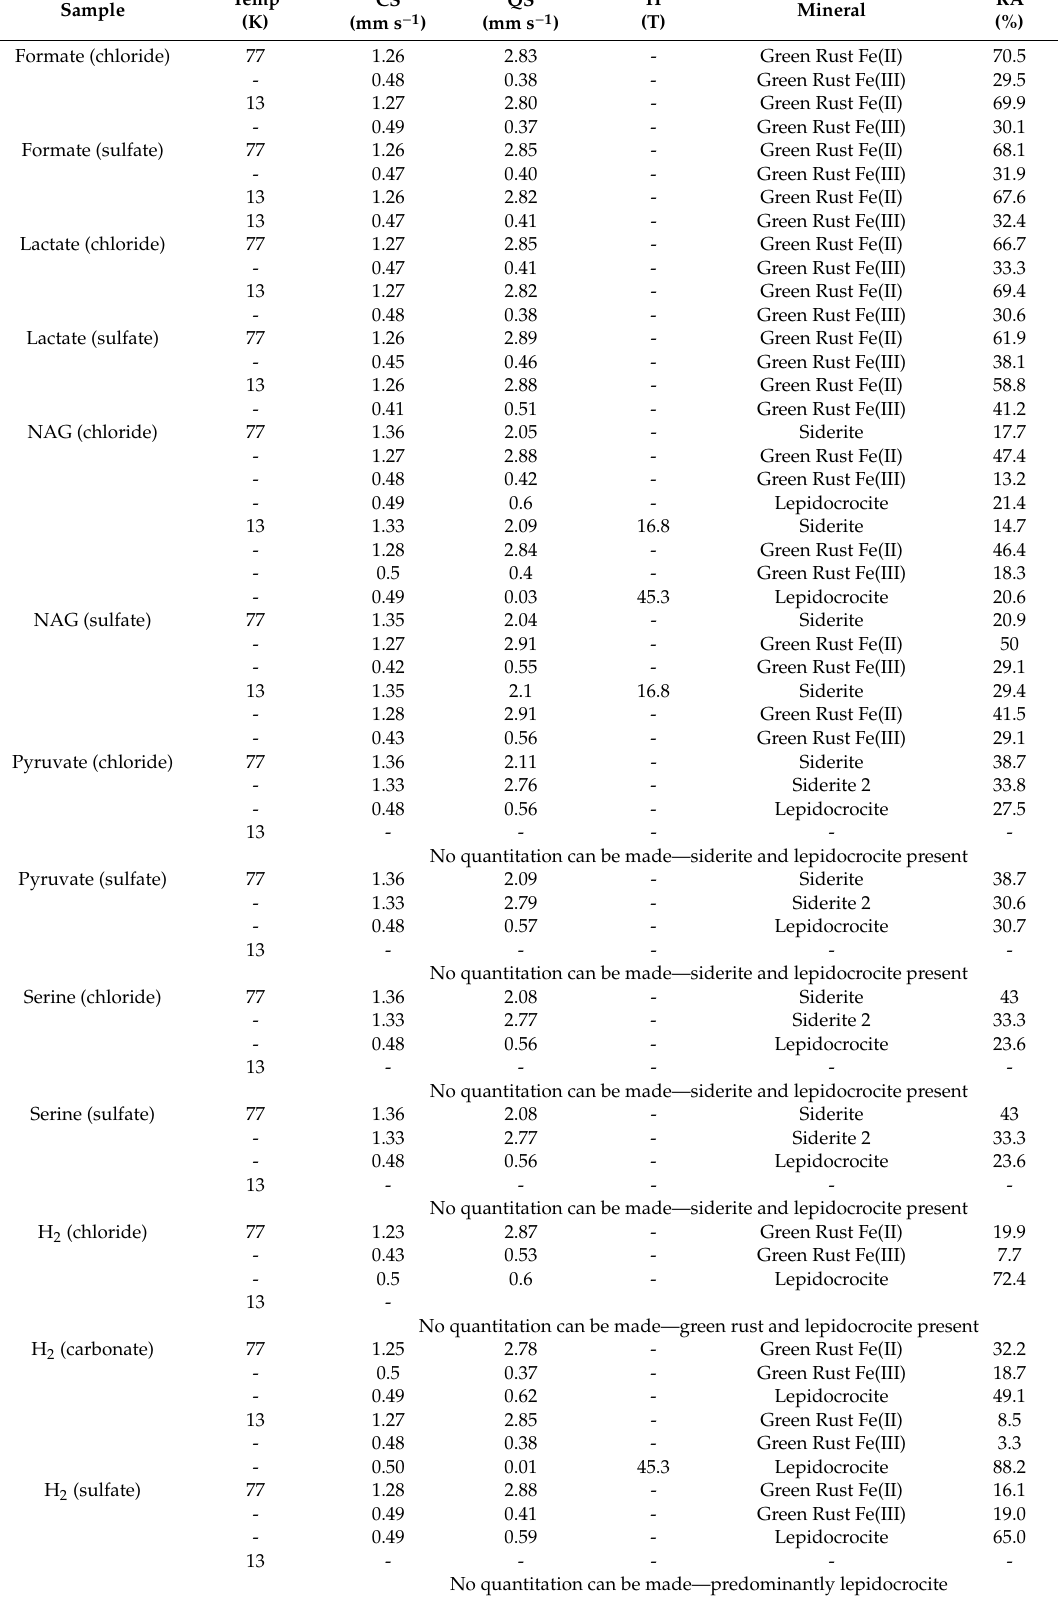
Table 2. Fit parameters from Mössbauer analysis of the secondary